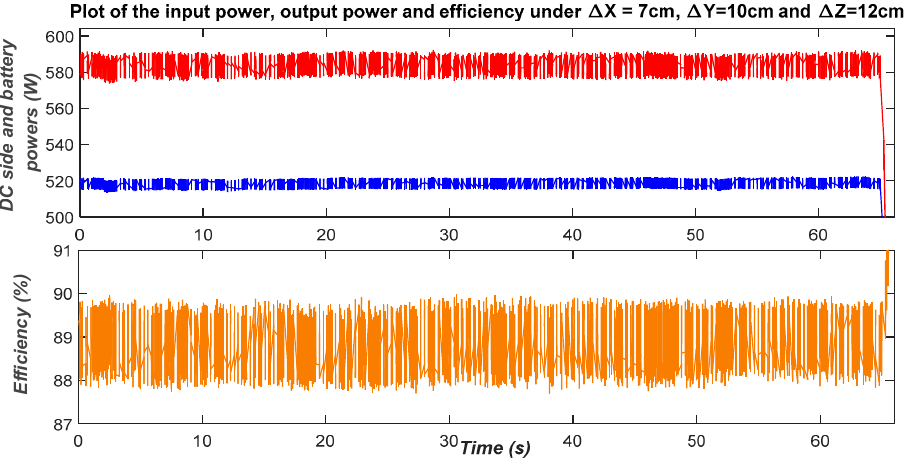
Figure 31. Variations of the DC-side power, battery power and efficiency in the presence of lateral misalignments (Vdc = 200 V, Δ x = 7 cm, Δ y = 10 cm and Δ z = 12 cm).